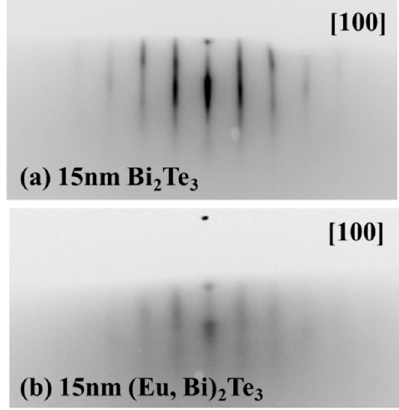
Figure 1. RHEED di ff raction patterns of ( a ) 15 nm thick Bi 2 Te 3 and ( b ) 15 nm thick (Bi, Eu) 2 Te 3 film right after deposition process.